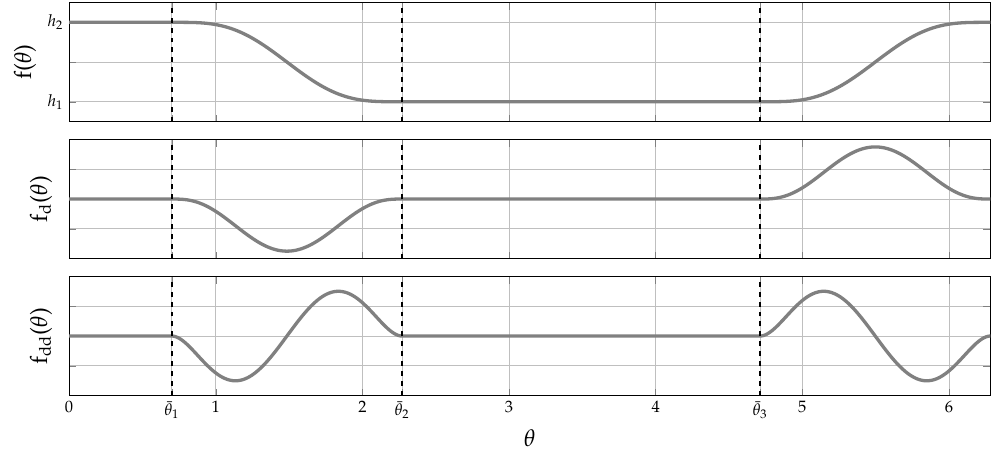
Figure 2. Follower kinematics motion: dwell–drop–dwell–rise.